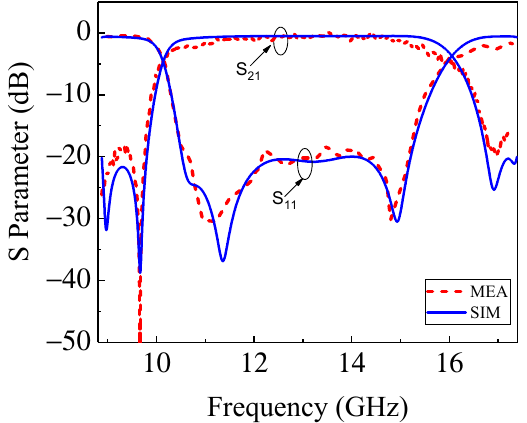
Figure 10. Measured S parameters of the proposed UWB filter.